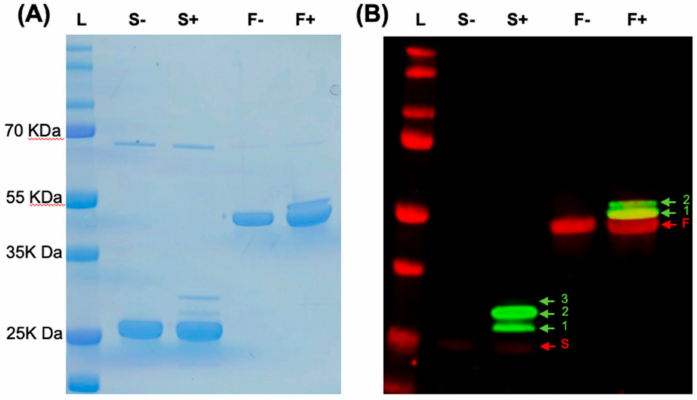
Figure 2. Novel glycoconjugate vaccines against C. jejuni . ( A ) SDS-PAGE was used to confirm the size of 6-His-purified FlpA (F) and SodB (S) produced in the presence of pACYC pgl :: pglB KO ( − ) and